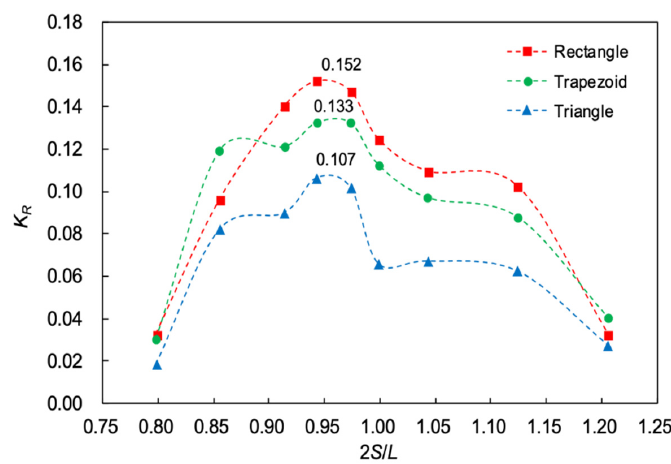
Figure 15. Influence of section shapes of bars on Bragg resonant reflection, N = 4, B = 0.2 m, D = 0.1 m, S = 1.0 m, φ = 68.85%, h = 0.25 m, and H = 0.04 m.